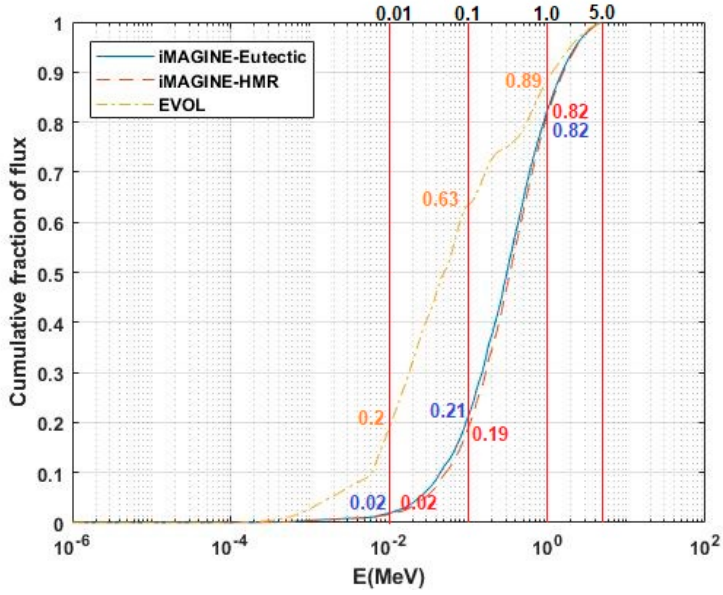
Figure 10. Cumulative fraction neutron-flux spectrum for iMAGINE and EVOL salt fuel systems.